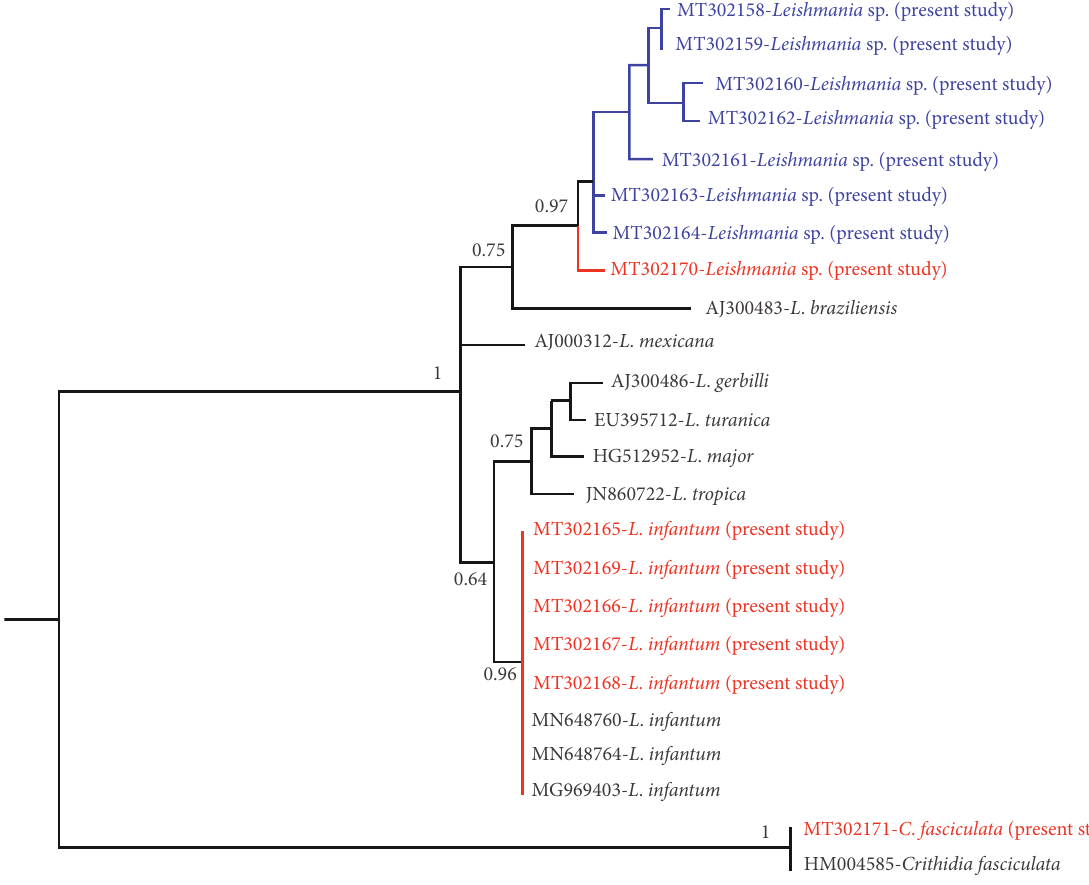
Figure 3: Phylogenetic tree of representative sequences of Leishmania from asymptomatic and symptomatic VL cases and reference sequences, based on the ITS1 fragment. Posterior probability values from the Bayesian analysis for nodes are indicated below or above branches. Samples isolated from asymptomatic and symptomatic cases are shown in red and blue color,